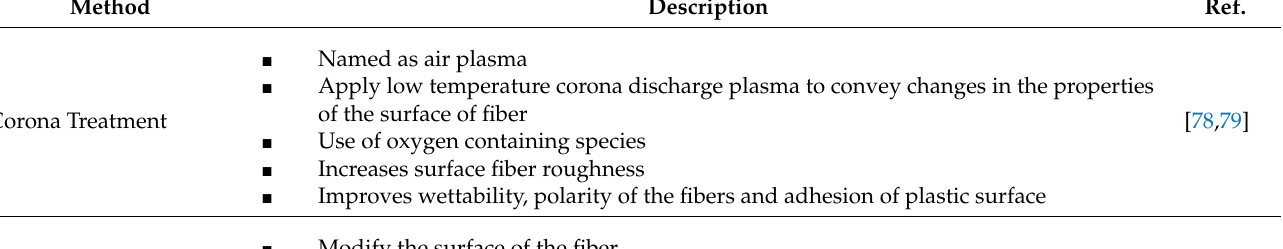
Table 6. Physical treatment for the modification of natural fibers. Method Description